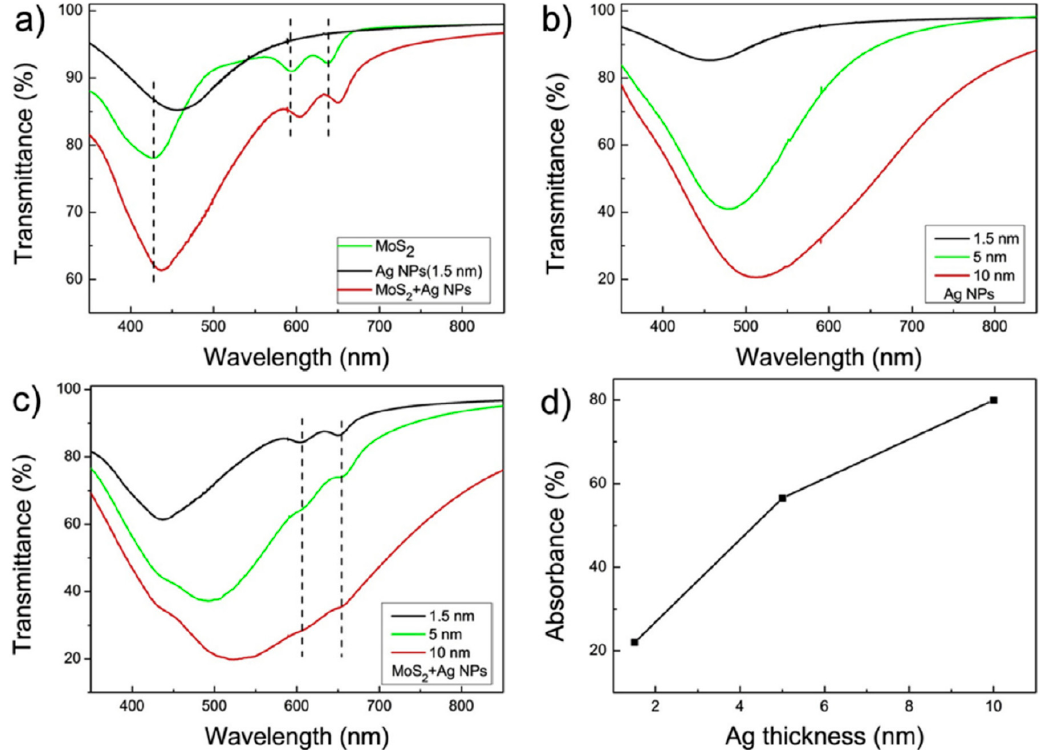
Figure 8. ( a ) The transmission spectra of Ag NPs, monolayer MoS 2 and MoS 2 -Ag NPs hybrids, ( b ) the transmission spectra of Ag NPs with different diameters, ( c ) the transmission spectra of MoS 2 -Ag NPs hybrids with different sizes of Ag NPs; ( d ) The absorbances for hybrids with different sizes Ag NPs at 532 nm [111].